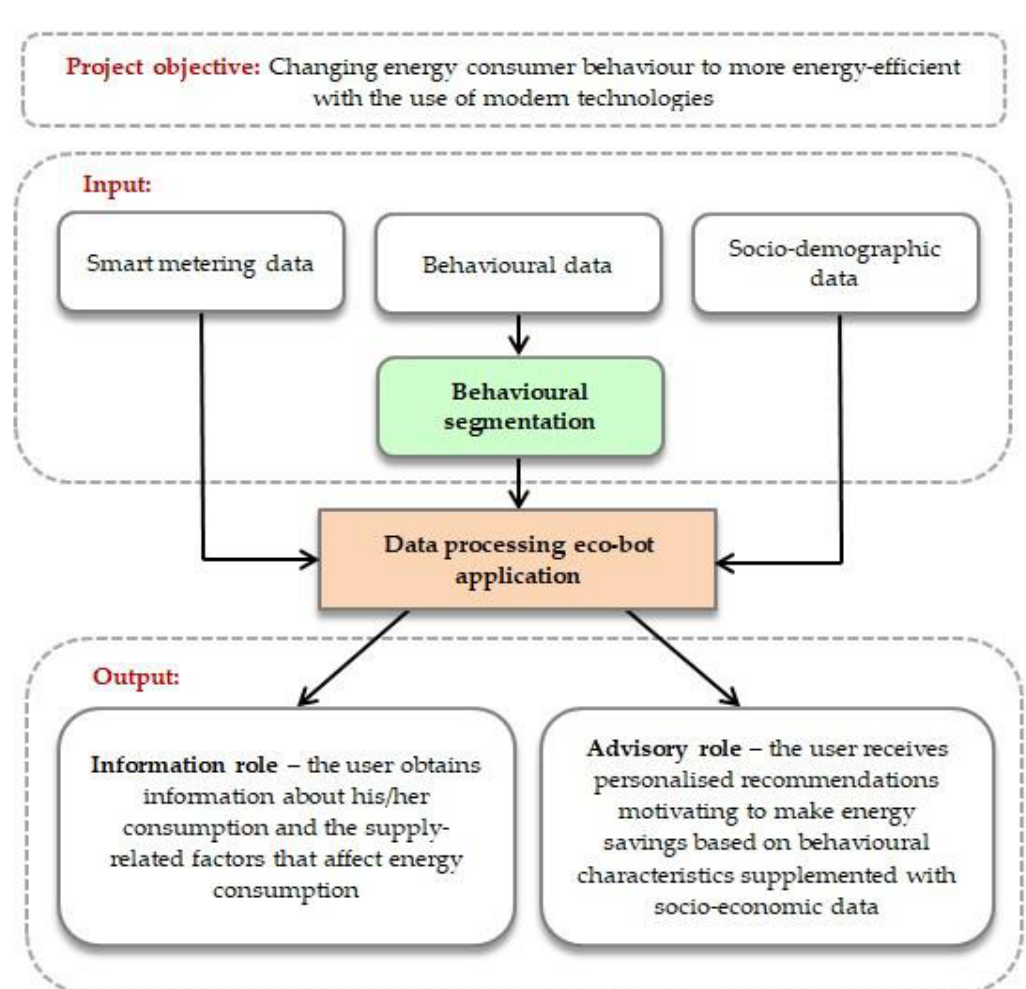
Figure 1. Main assumptions of the eco-bot project.